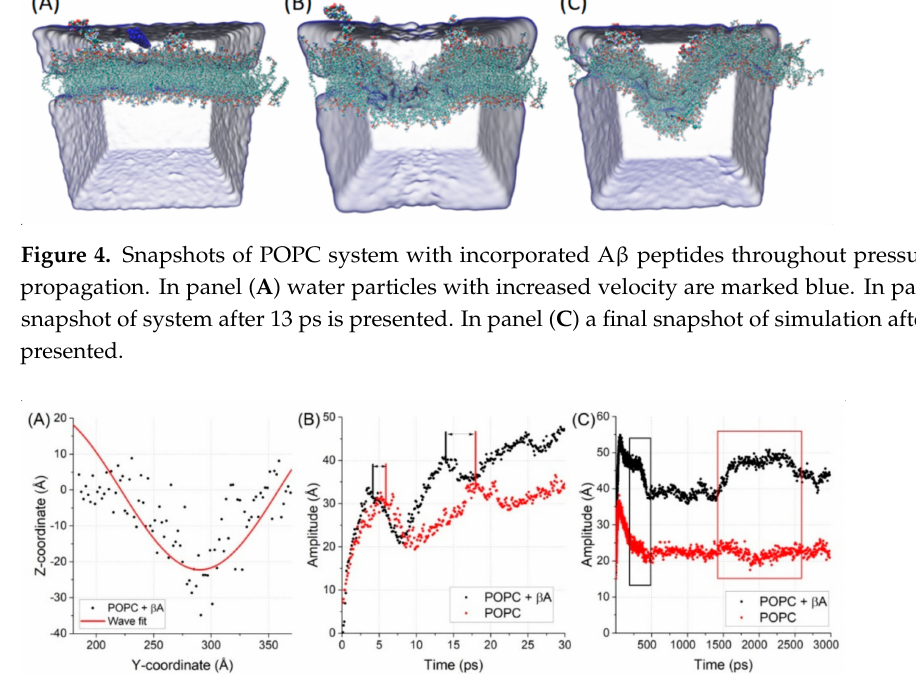
Figure 5. In panel ( A ) the fitting of sin function to histogrammed phosphorus atoms’ positions to determine the characteristics of the wave. In panel ( B ) and ( C ) evolution of the amplitude is presented in shorter and longer times of the simulations,